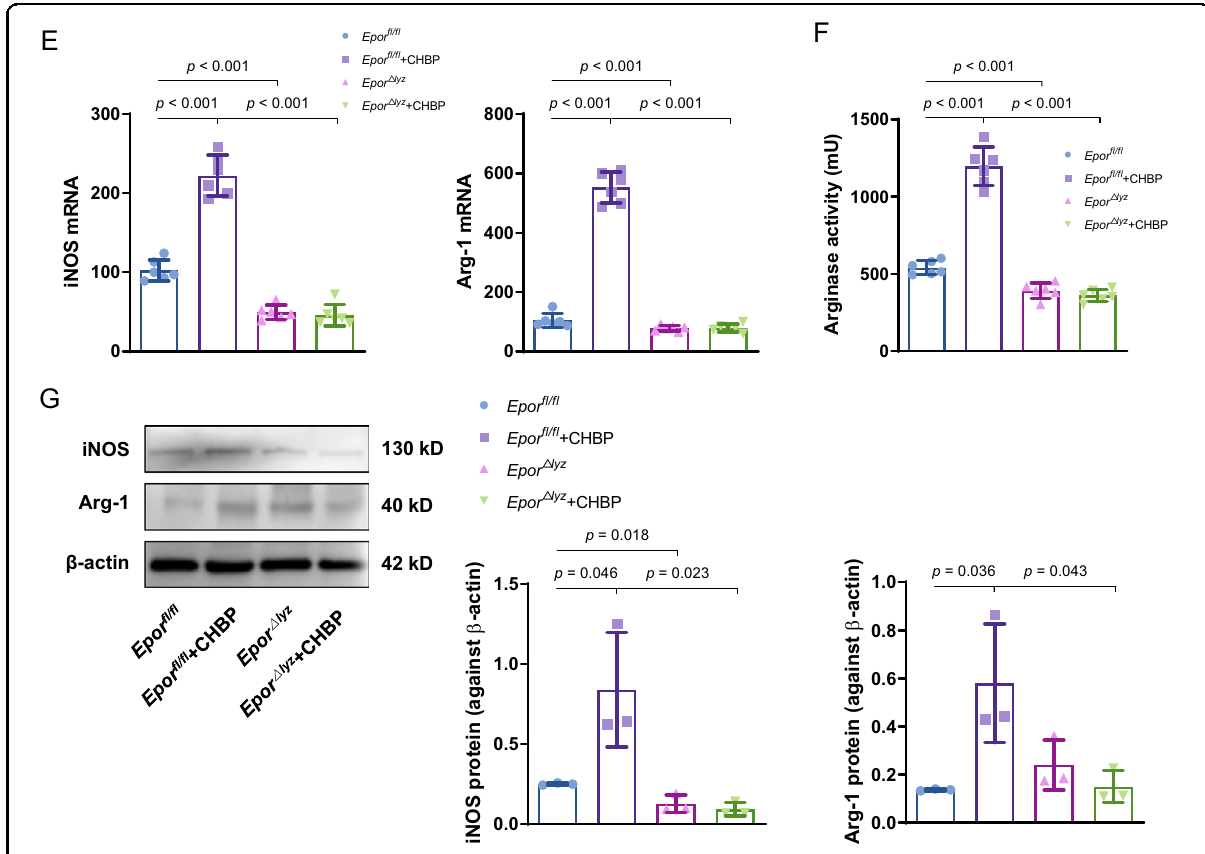
Fig. 4 The effects of CHBP on MDSCs were dependent on EPOR. A Detection of CD11b + Ly6G − Ly6C high M-MDSCs and CD11b + Ly6G + Ly6C low G-MDSCs by fl ow cytometry. B Quanti fi cation analysis of the G-MDSCs and M-MDSCs proportions. C T-cell proliferation detected by CFSE. The ratios of G-MDSCs and T cells were 1:2, 1:4, 1:8, 1:16, and 1:32. D T-cell proliferation detected by CFSE. The ratios of M-MDSCs and T cells were 1:2, 1:4, 1:8, 1:16, and 1:32. E The expressions of iNOS and Arg-1 by qPCR. F The arginase-1 activity. G The protein expressions of iNOS and Arg-1 by western